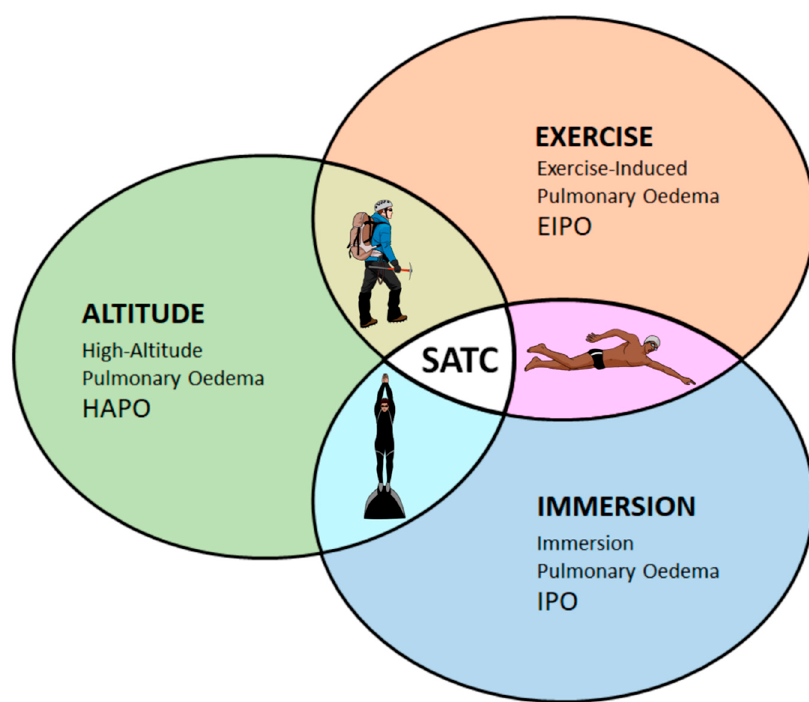
Figure 1. Schematic representation of external stimuli for the development of environmental-induced pulmonary oedema in healthy individuals. At high altitude, mountaineers are exposed to the effects of hypoxic pulmonary vasoconstriction, and increased pulmonary blood flow during exercise, thus developing the risk for high-altitude pulmonary oedema. Breath-holding divers suffer the simultaneous effects of hypoxia, central blood-shift, and chest compression. Swimmers experience hemodynamic changes in pulmonary circulation during exercise, due to regular breath-holding pattern and chest compression. SATC (swimming altitude training camp) combines all three forms of environmental stress that can elicit sub-clinical pulmonary oedema. Based on Marabotti et al. [2].